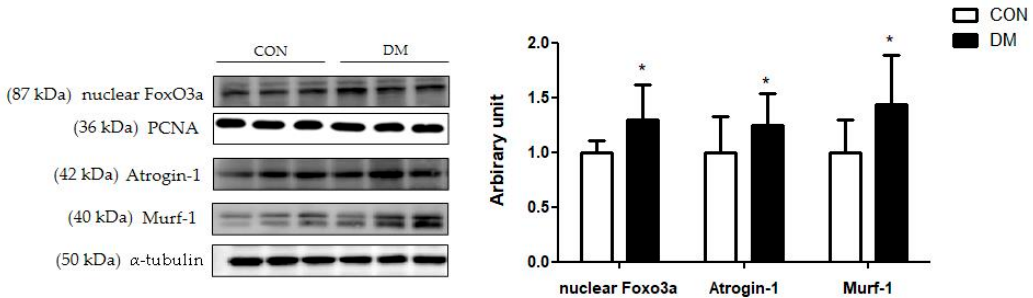
Figure 8. Skeletal muscle degradation related markers in T2DM mice All values are reported as mean and SD. The asterisk represents the statistical significance of differences from * p < 0.05. n = 9 mice in each group. CON, normal control mice; DM, diabetes mellitus mice.